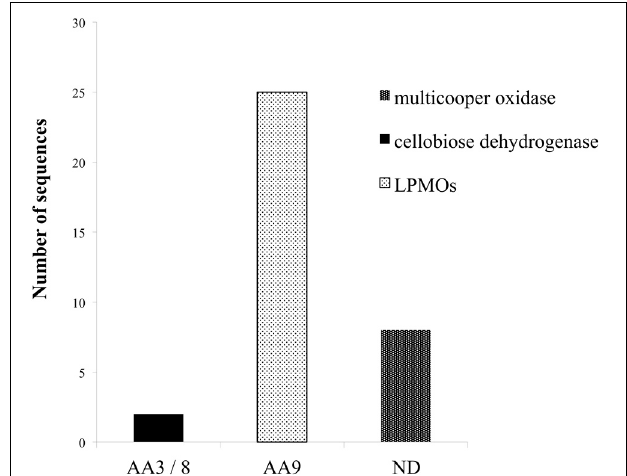
FIGURE 4 | Distribution of enzymes of M. thermophila with auxiliary activities, classified to AA3/8, AA9 families and multicopper oxidases. M. thermophila distinguishes itself from other cellulolytic fungi, exhibiting an impressing number of LPMOs accessory enzymes belonging to AA9 family (previously described as